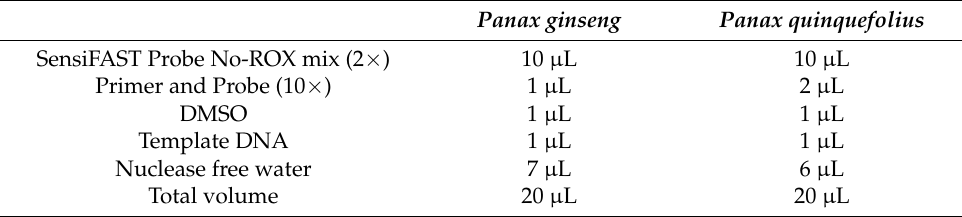
Table 2. Ingredients of real-time qPCR used for P. ginseng and P. quinquefolius assays. Panax ginseng Panax quinquefolius SensiFAST Probe No-ROX mix (2 × ) 10 µ L 10 µ L Primer and Probe (10 × ) 1 µ L 2 µ L DMSO 1 µ L 1 µ L Template DNA 1 µ L 1 µ L Nuclease free water 7 µ L 6 µ L Total volume 20 µ L 20 µ